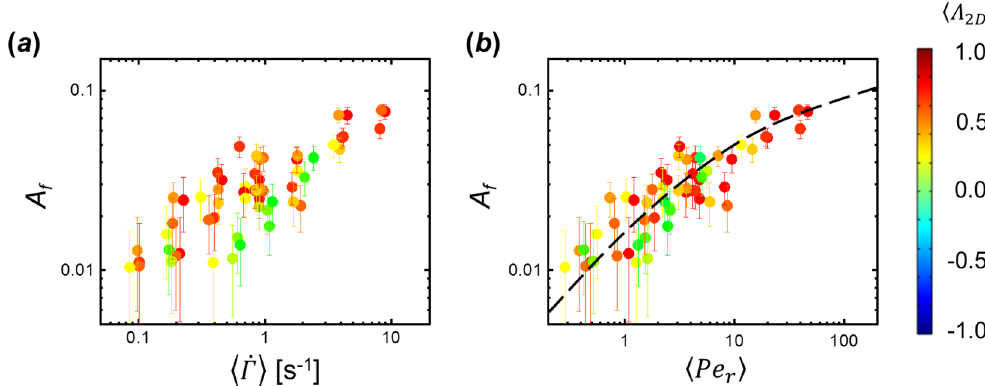
Figure 13. A f vs. ( a ) average magnitude of velocity gradient tensor ( Γ  ) and ( b ) average rotational Peclét number ( Pe r ). The color of plotted points indicates the average flow type ( Λ 2 D ) where red indicates an extensional flow ( Λ 2 D = 1) and green indicates a shear flow ( Λ 2 D = 0). Data for which A f falls below the lowest resolvable value ( A f ~ 0.01) are suppressed. The black line in ( b ) is a spline fit included as a guide to the eye. Error bars correspond to variability in the SANS pattern over the q-range used in Equation